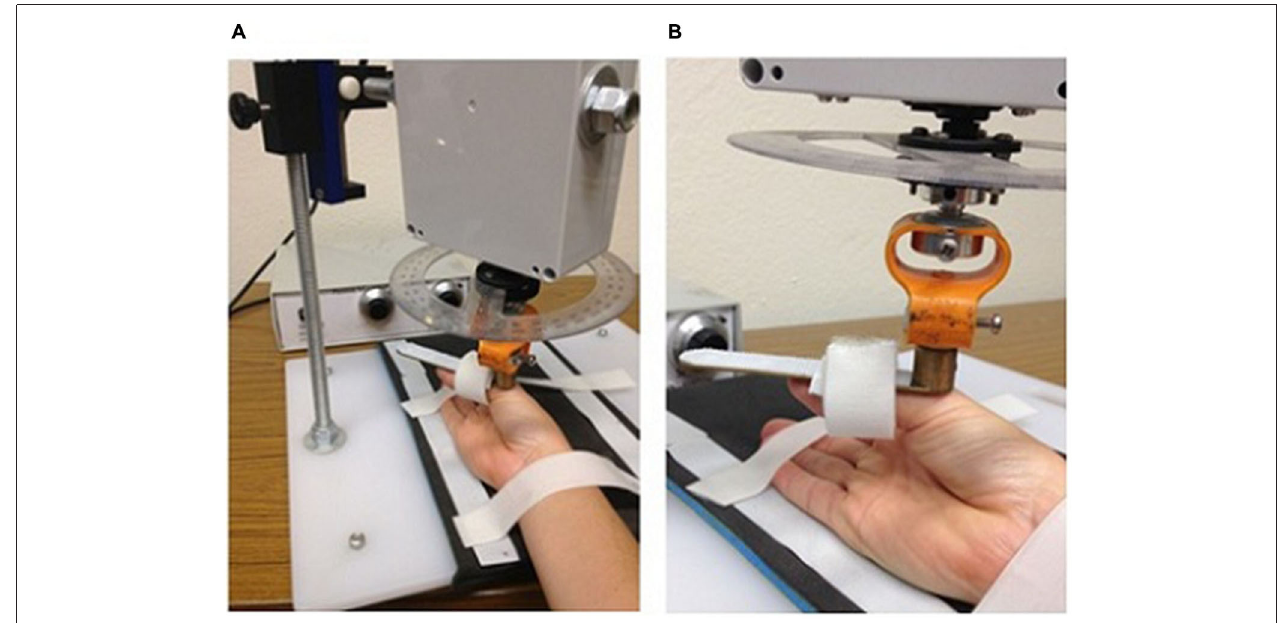
FIGURE 1 | Custom-made device to passively move the thumb carpometacarpal joint through a range of flexion/abduction and extension/adduction . Panels demonstrate the position of the arm (A) and hand (B) .